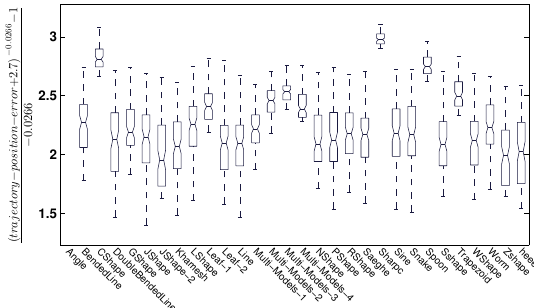
(b) The inter-shape performance is illustrated in this plot. The plot displays the performance for each shape in the generaliza- tion benchmark scenario.